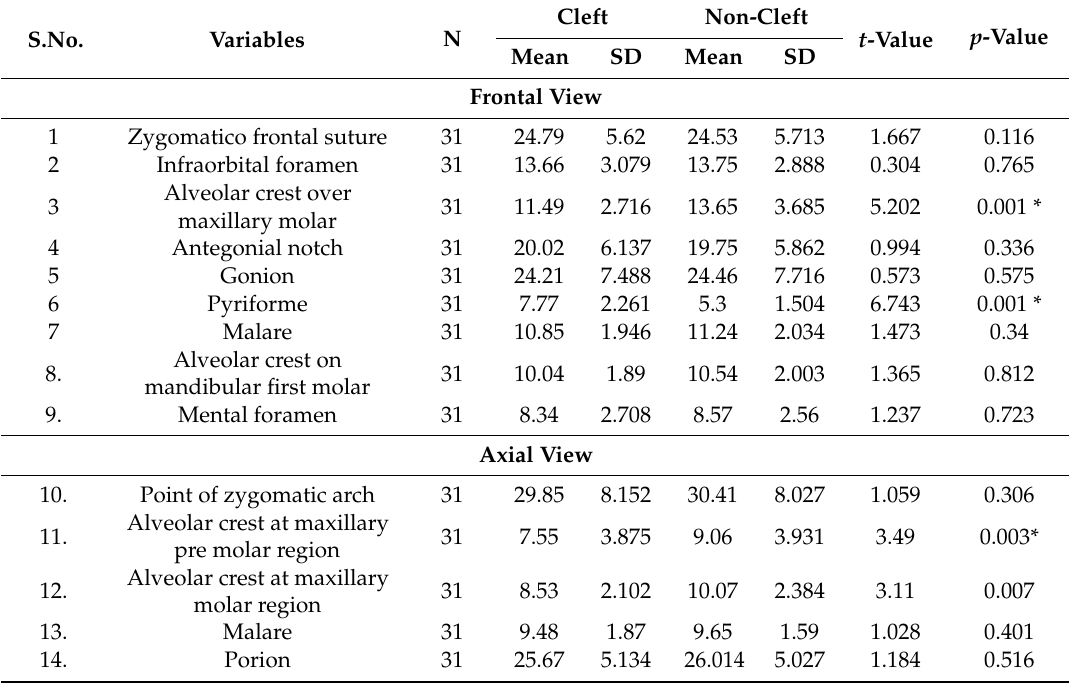
Table 3. Comparison of the values between the cleft and non-cleft